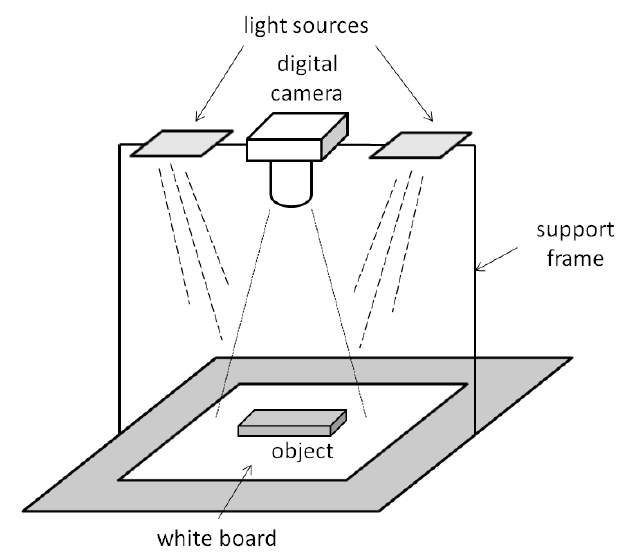
Figure 1. Image-acquisition station scheme (source: own materials).